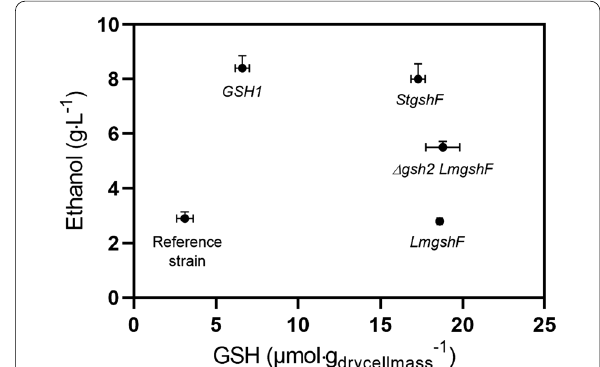
Fig. 4 Correlation between intracellular GSH levels measured in a defined mineral medium and the ethanol titres obtained during SSF with 10% WIS. The data are the means and standard deviation (n